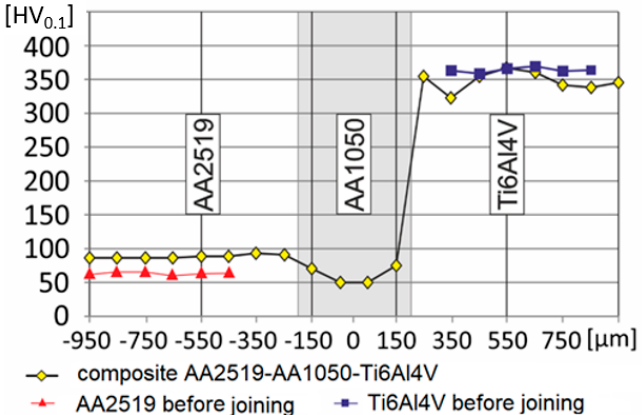
Figure 4. Microhardness distribution in the AA2519-AA1050-Ti6Al4V laminate.